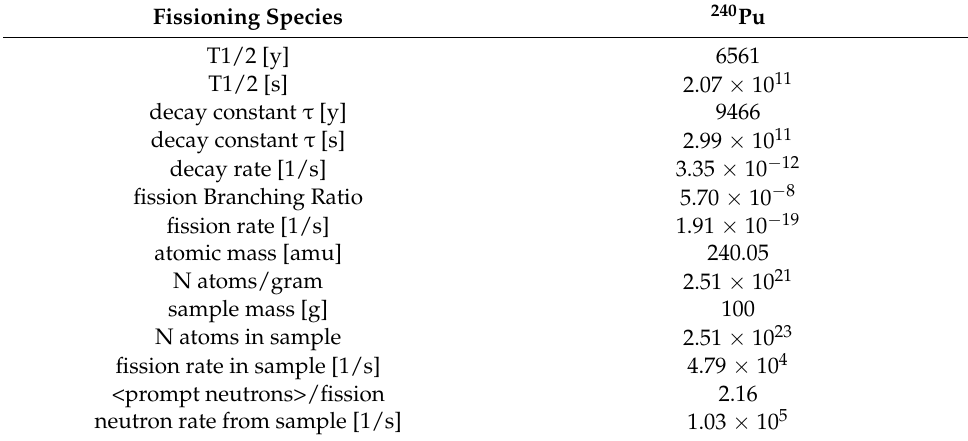
Table 2. Calculation of the rate of fission neutrons produced by 100 g of 240 Pu (the relevant nuclear data were taken from [27]).